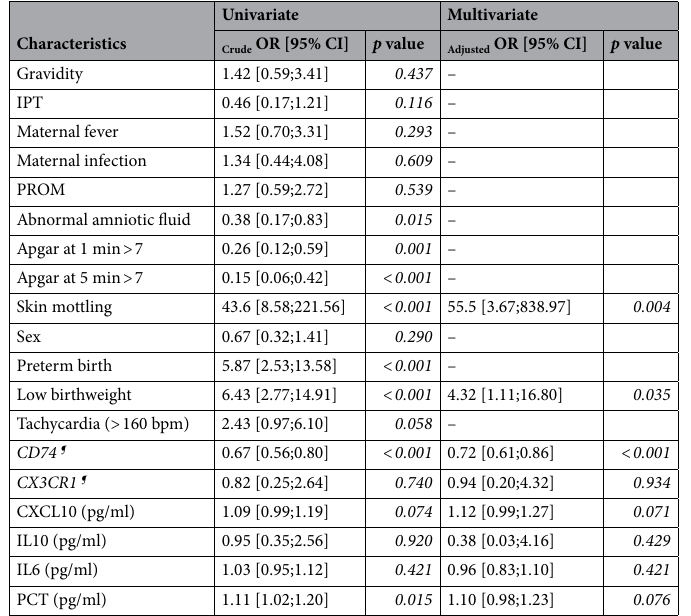
Table 7. Factors associated with infant’s death using univariate and multivariate logistic regression models. IPT, intermittent preventive treatment against malaria; CD74 , HLA class II histocompatibility antigen gamma chain; CX3CR1; CX3C chemokine receptor 1; IL , Interleukin; PCT, procalcitonin. ¶ CD74 and CX3CR1 are expressed as relative expression to HPRT1.